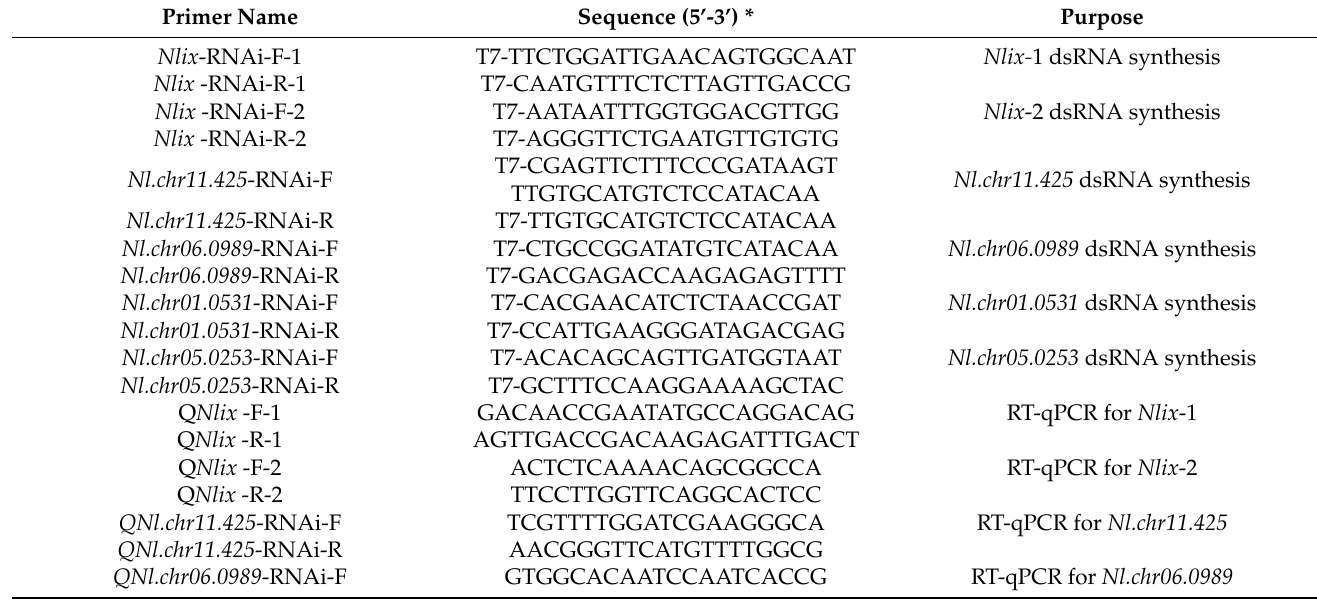
Table A1. The main primers used in this